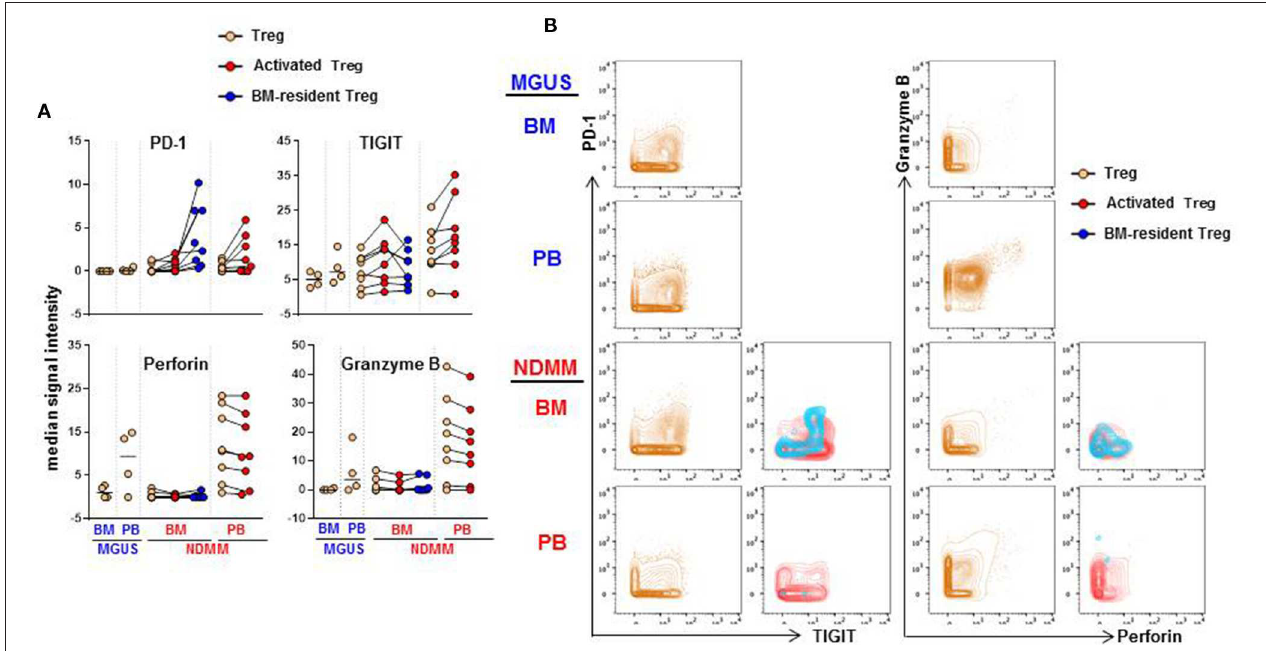
FIGURE 6 | Expression of PD-1, TIGIT, Perforin and Granzyme B on activated CD39 − Treg and BM-resident CD39 − Treg (A) . Median signal intensity of PD-1, TIGIT, Perforin. and Granzyme B defined by biaxial gating in total Treg, activated CD39 − Treg and BM-resident CD39 − Treg in BM and PB of MGUS ( n = 4) and NDMM ( n = 8) patients. Total Treg, activated CD39 − Treg and BM-resident CD39 − Treg from individual NDMM patients were connected. (B) Representative biaxial plots of PD-1 vs. TIGIT and Granzyme B vs. Perforin expression in total Treg, activated CD39 − Treg and BM-resident CD39 − Treg in matched BM and PB of individual MGUS and NDMM